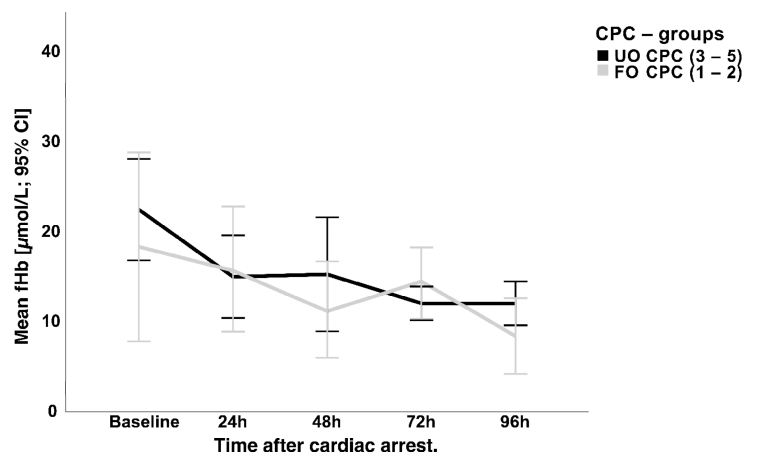
Figure 4. FHb levels compared between the two CPC outcome groups during the first 96 h after VA-ECMO initiation. CPC = cerebral performance category scale; fHb = free hemoglobin; CI = confi- dence